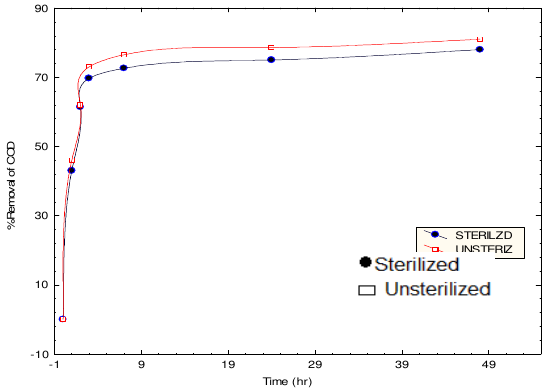
Fig. 6. Effect of sterilization on the concentration level of TOC pollutant with time at T=25 o C, pH 7, wastewater/(Algae broth) ratio =1.